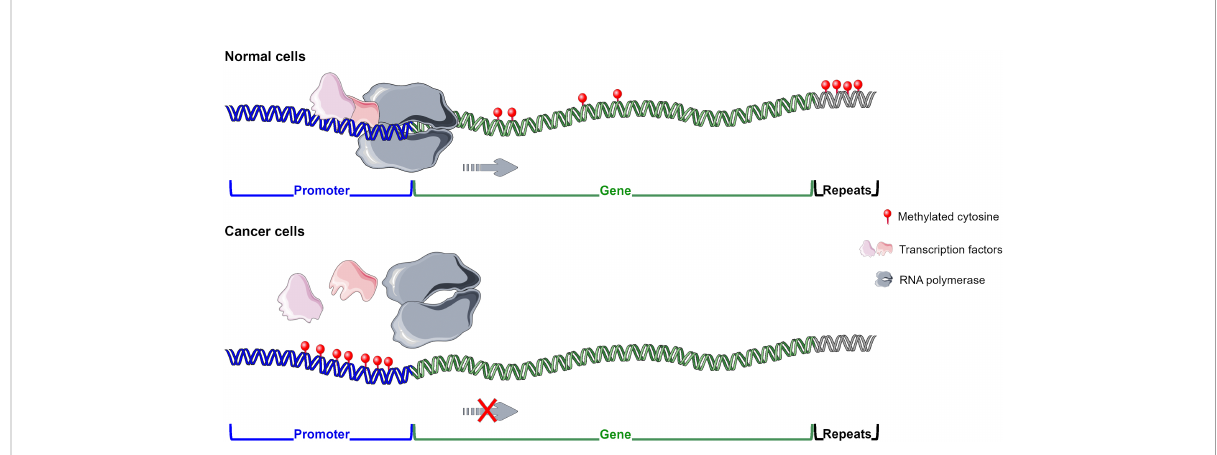
FIGURE 1 DNA methylation pattern in normal and cancer cells. In normal cells methyl group is widely distributed except for CGIs located at promoters and enhancers of tumour suppressor genes enabling their transcription. In cancer cells hypermethylation is generally observed at regulatory regions of tumour suppressor genes inhibiting their expression, whereas global hypomethylation is detected. Figure created using Servier Medical Art images, licensed under a Creative Commons Attribution 3.0 Unported License;